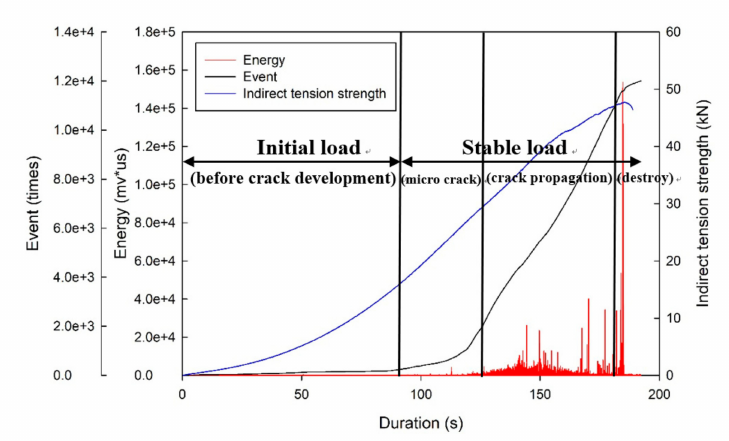
Figure 11. Application of AE in the split tensile test to monitor the destruction